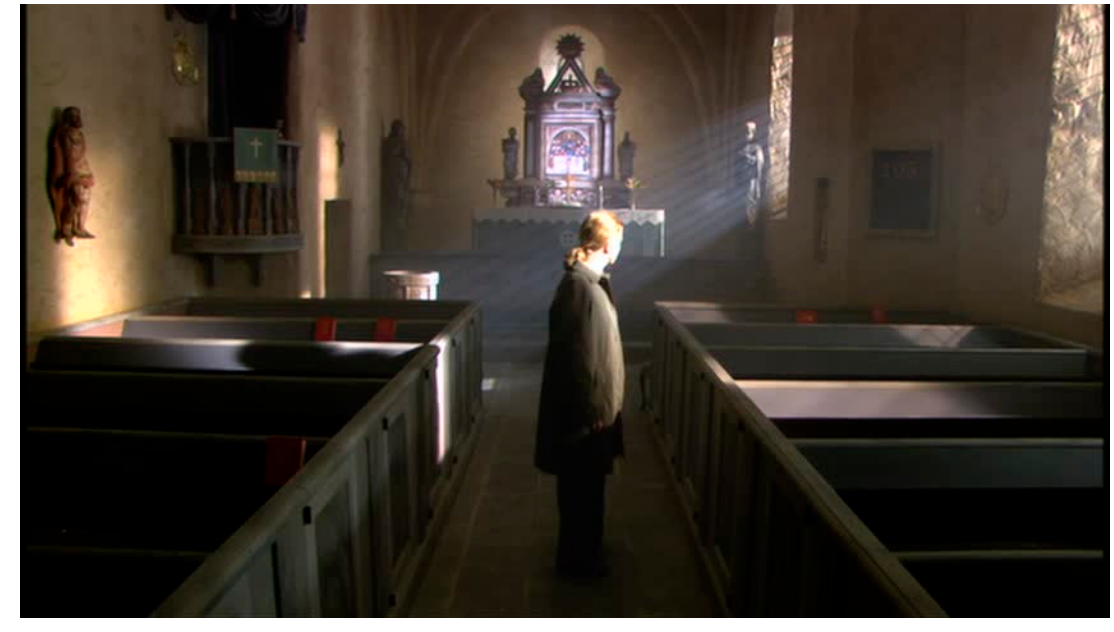
Figure 18. Light, Art, Prayer.